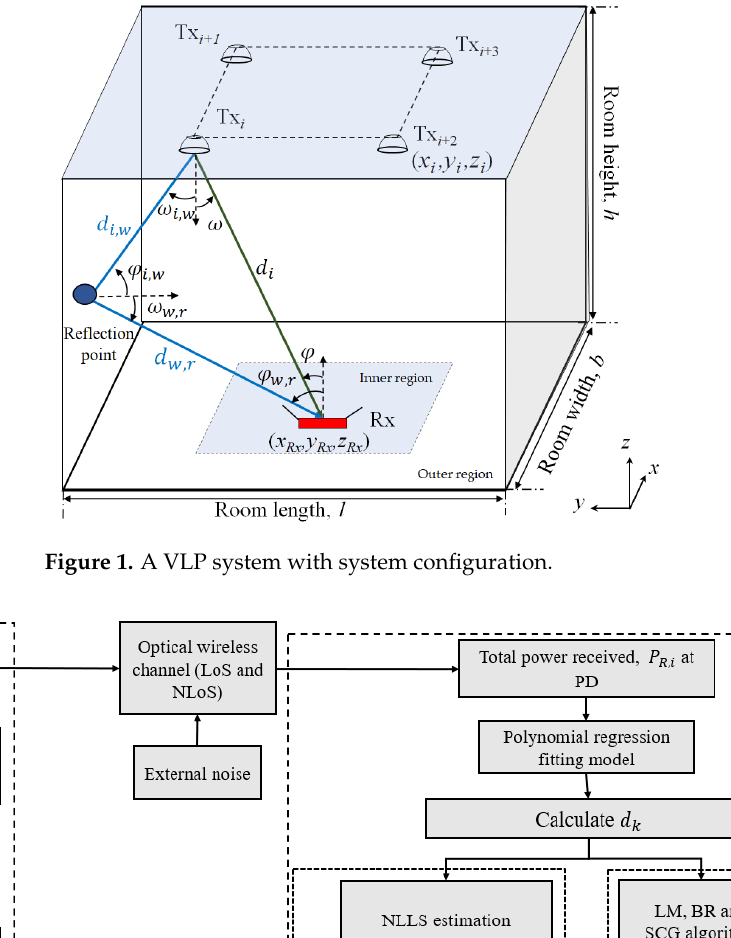
Figure 1. A VLP system with system configuration.